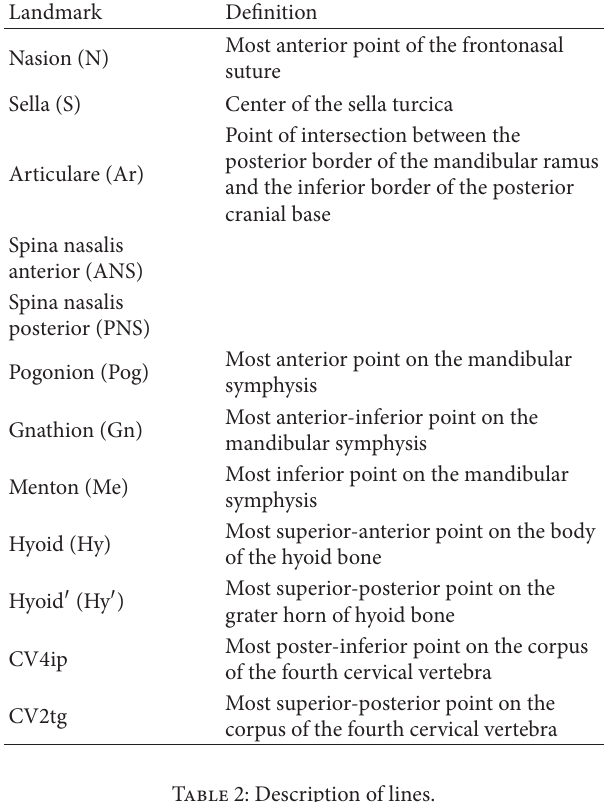
Table 1: Description of landmarks.